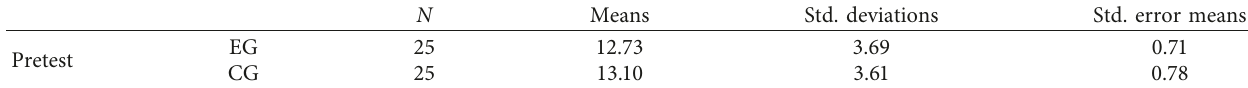
Table 1: DS of the pretest of both